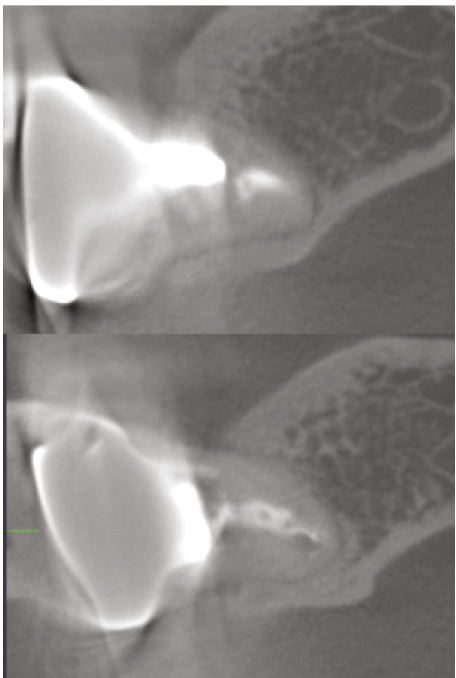
Figure 9: CBCT revealed the presence of buccal and lingual bone on both mesial (a) and distal (b) roots of the transplanted tooth.